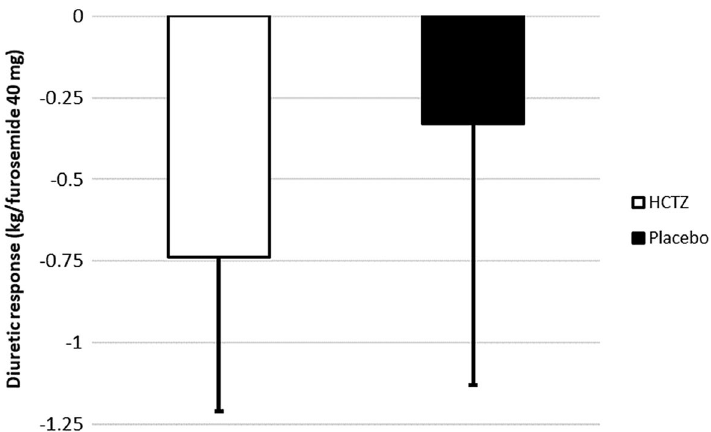
Figure 5. Diuretic response—weight change for every 40 mg of furosemide in the HCTZ and placebo groups. Values are reported as mean ± standard deviation (kg/40 mg of furosemide). HCTZ: − 0.74 ± 0.47 kg/40 mg; placebo: − 0.33 ± 0.80 kg/40 mg; p = 0.032.